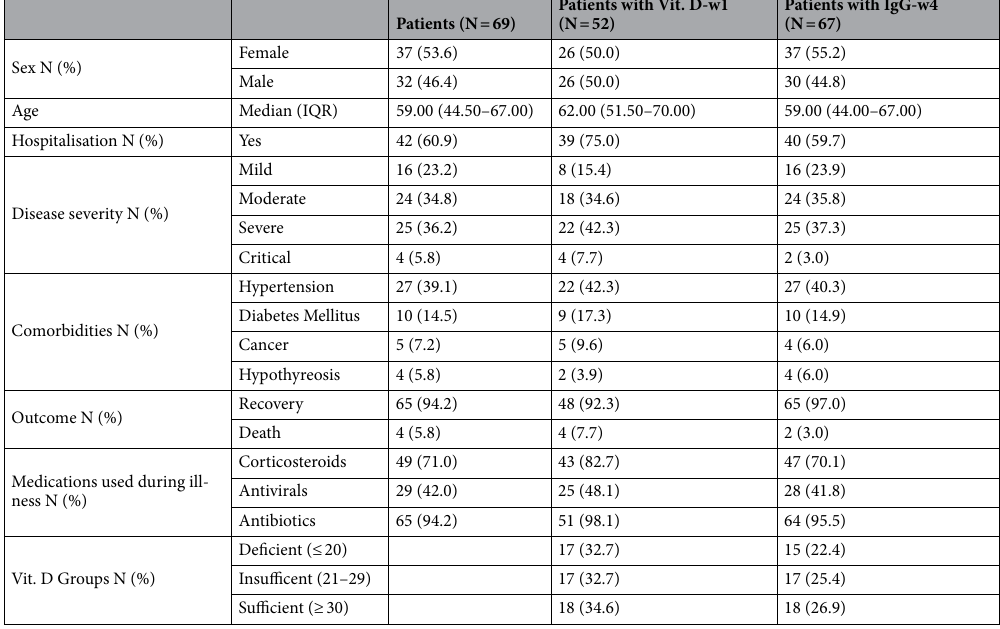
Table 1. Patients